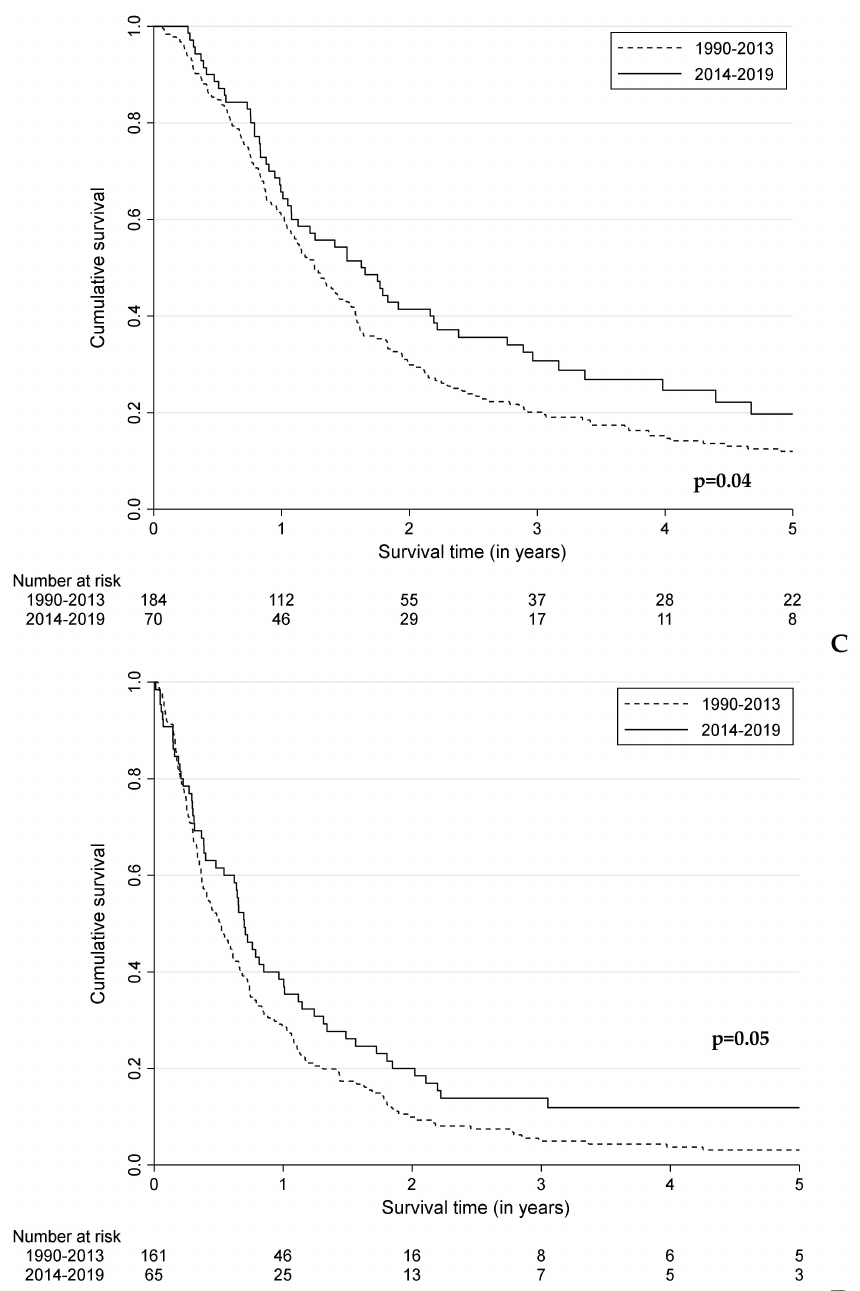
Figure 3. Kaplan–Meier curves representing the overall survival of patients with MM according to the period of diagnosis for ( A ) the total population, ( B ) local or locally advanced disease, ( C ) locoregional spread disease, and ( D ) distant spread